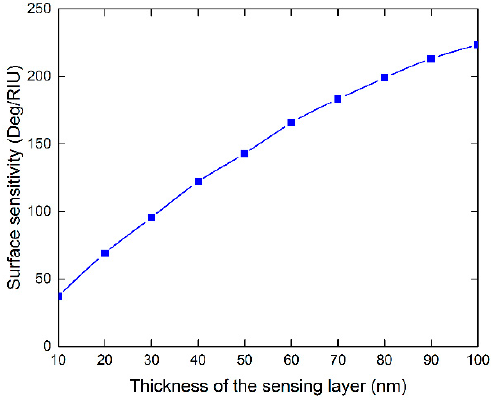
Figure 3. The change in surface sensitivity as the function of the thickness of biomolecules on the surface.